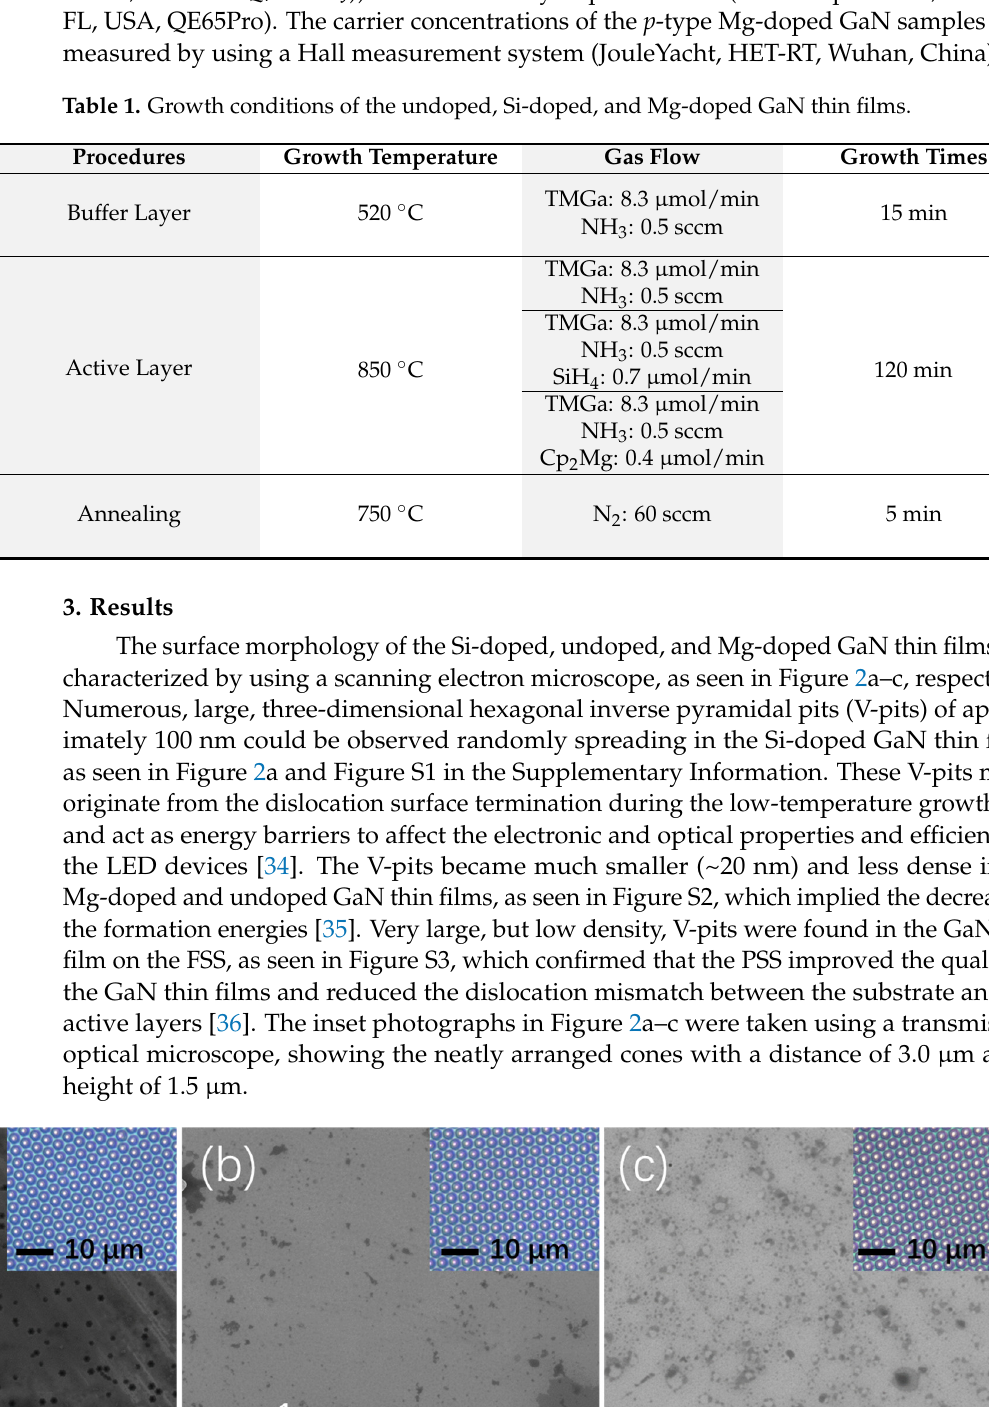
GaN thin films and decreased to 3.23 eV in the Si-doped GaN thin films. This indicated that the magnesium ions and silicon ions were successfully doped into the GaN lattice structure. Normalized photoluminescence spectra of these samples were also recorded, as seen in Figure 3b; the emission peaks located at 370.3 nm (Mg-doped GaN), 372.3 nm (un- doped GaN), and 403.6 nm (Si-doped GaN) were observed. The fluorescence emission centers of the undoped and Mg-doped GaN thin films were attributed to the radiative near-band-edge emission, and that of the Si-doped GaN came from the donor acceptor pair (DAP) recombination. To explore the energy structure in all the samples, the defect luminescence spectra of the samples were also studied at room temperature, as seen in Figure 3c–e. Broadband green luminescence (GL) and yellow luminescence (YL) could be seen in the defect luminescence spectra of the samples, corresponding to the Ga N and N Ga defects and the defect complex of V Ga -O N [37–39]. The defect luminescence of the Si-doped GaN thin film was nearly 15 times more intense than that of the undoped GaN and 40 times more intense than that of the Mg-doped GaN, which implied different densities of defects in the thin films. All of these optical differences, such as bandgap, photolumines- cence, and defect density, affected the luminescence and laser properties of the samples, and this will be discussed in more detail in the discussion section.